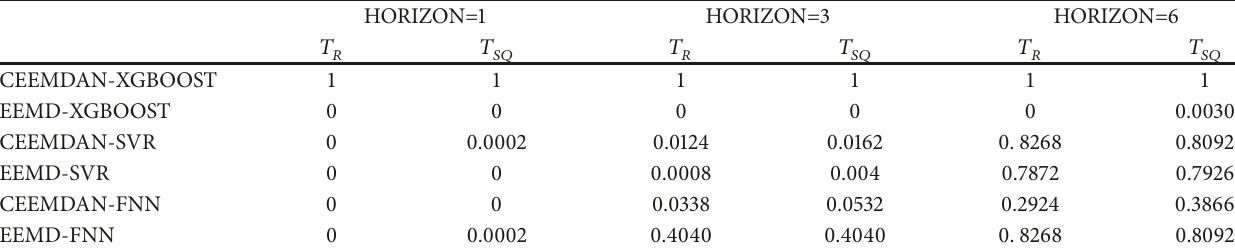
Table 7: MCS between XGBOOST, SVR, and FNN with EEMD or CEEMDAN. HORIZON=1